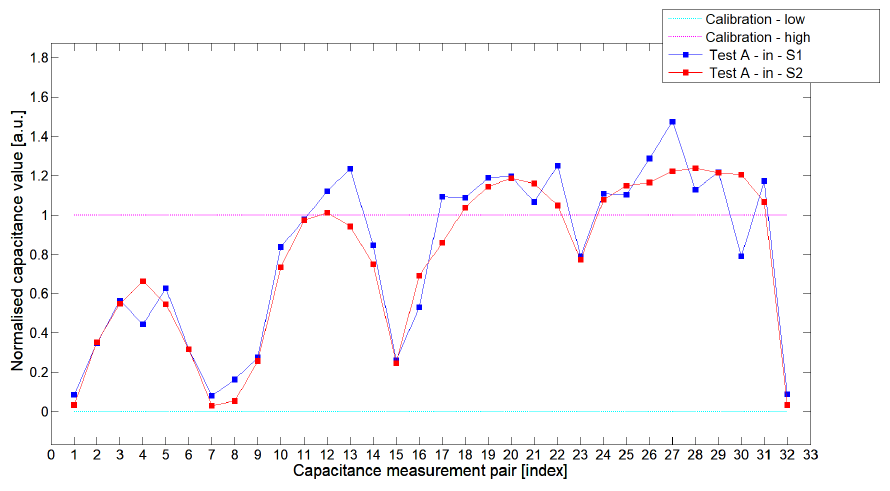
Figure 8. The 1st electrode measurement cycle (S1: 1->32 and S2: 1->32)for Test A in and S1—blue line, S2—red line. Cyan and magenta lines indicate calibration limits